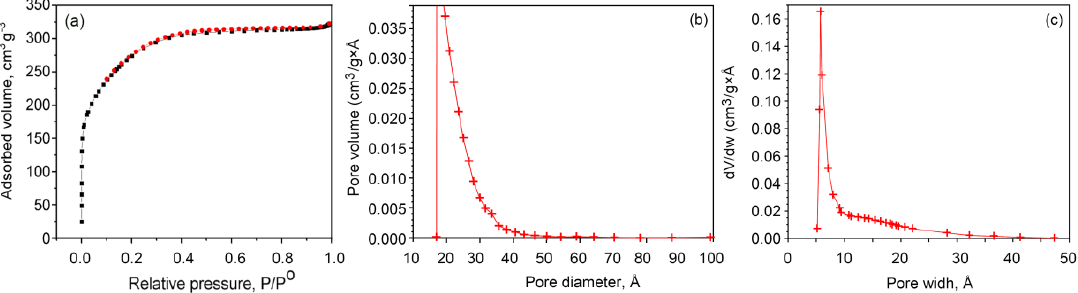
Figure 3. ( a ) N 2 adsorption and desorption, and ( b – c ) the pore-size distribution of the 3D nitrogen self-doped graphene-based carbon aerogel activated at 800 °C: ( b ) Barrett−Joyner−Halenda pore distribution curve of the pore volume as a function of the pore diameter. (c) Horvath−Kawazoe differential pore volume plot.